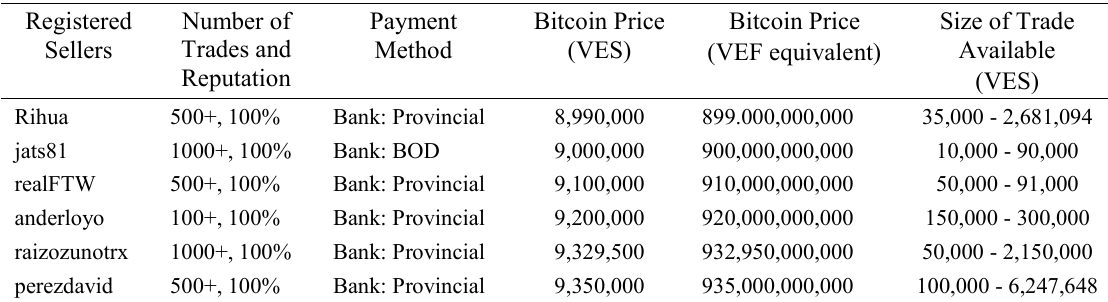
Table 2. Bitcoins for Sale by Registered Sellers listing Payment and Transaction Options: